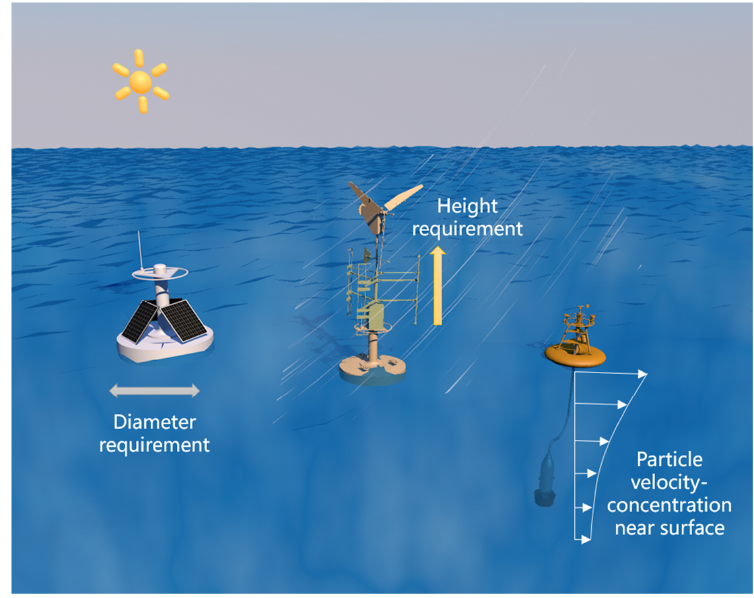
Figure 1. Engineering challenges for various power systems on